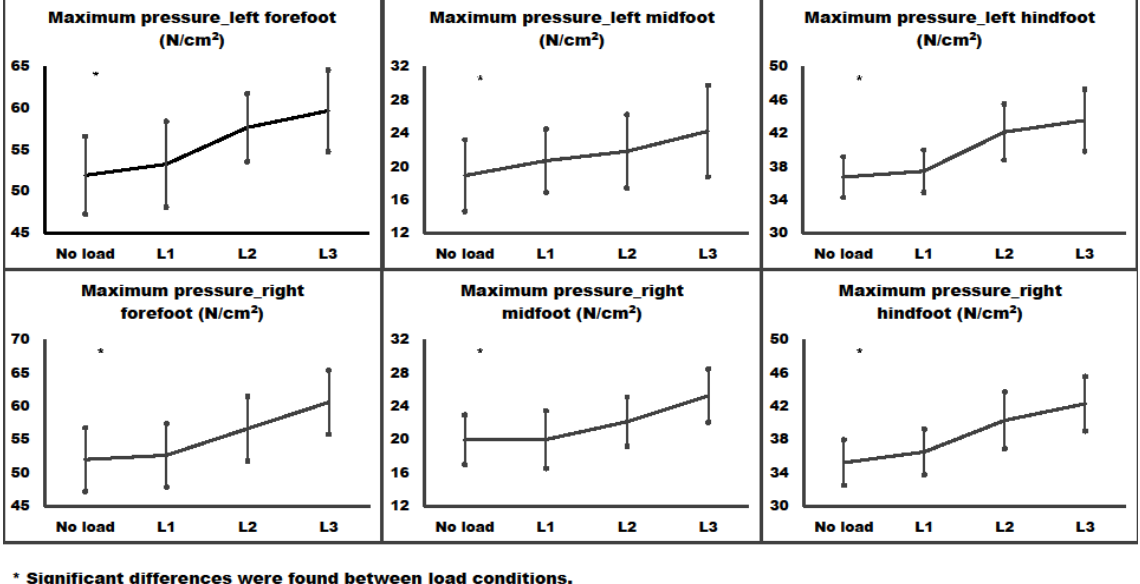
Figure 4. Changes in plantar pressures beneath specific foot regions under different loading condi- tions (N =